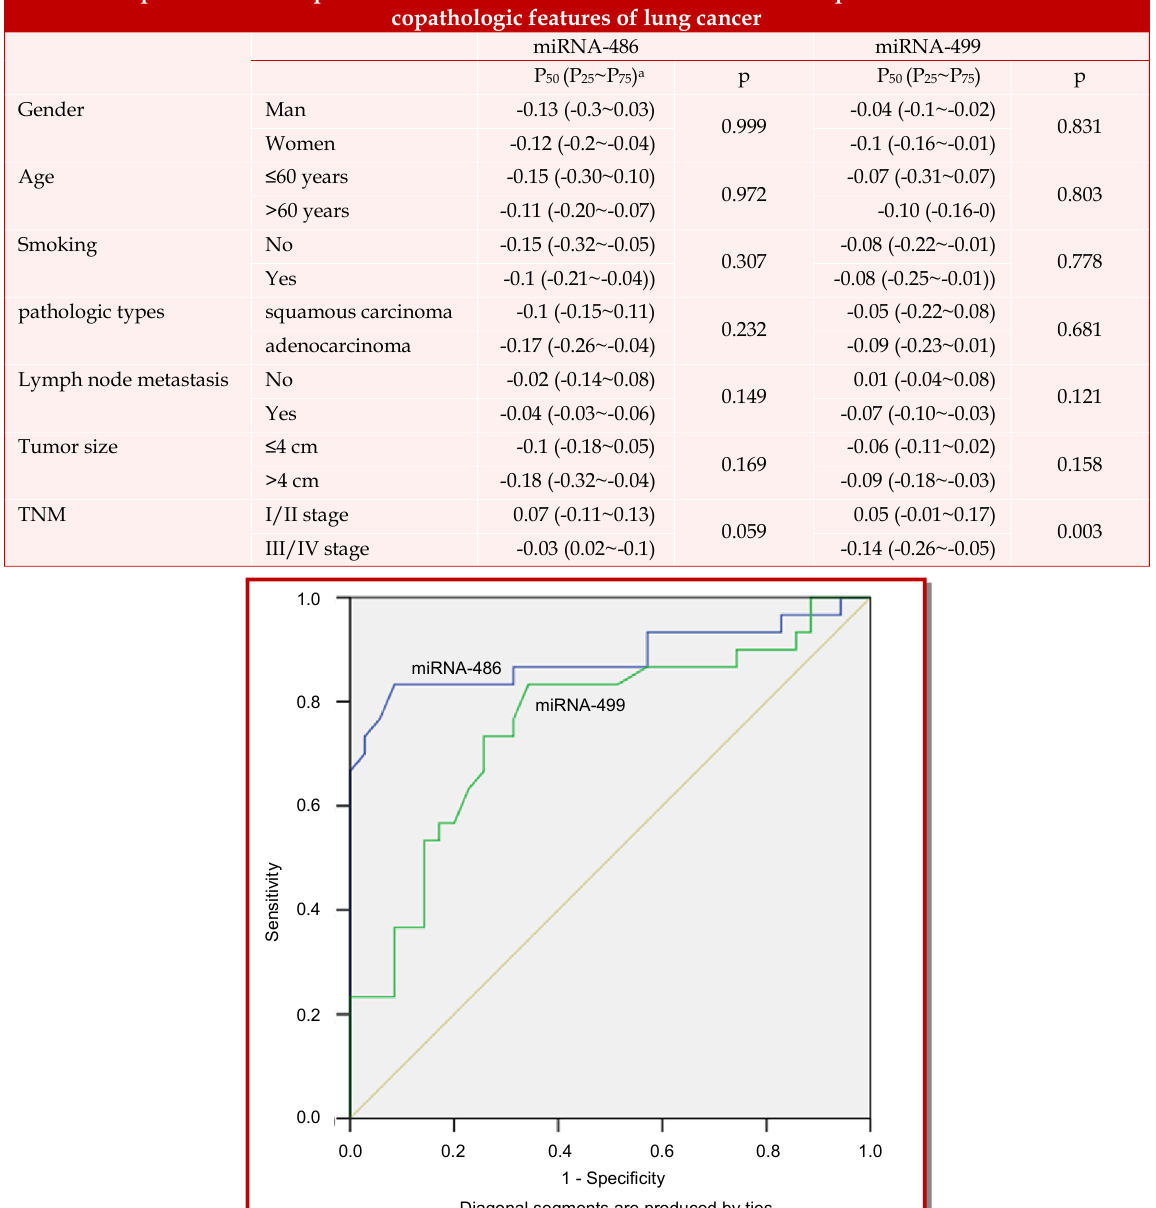
Relationship between the expression of the miRNA-486 and miRNA-499 in the plasma of NSCLC with clini- copathologic features of lung cancer